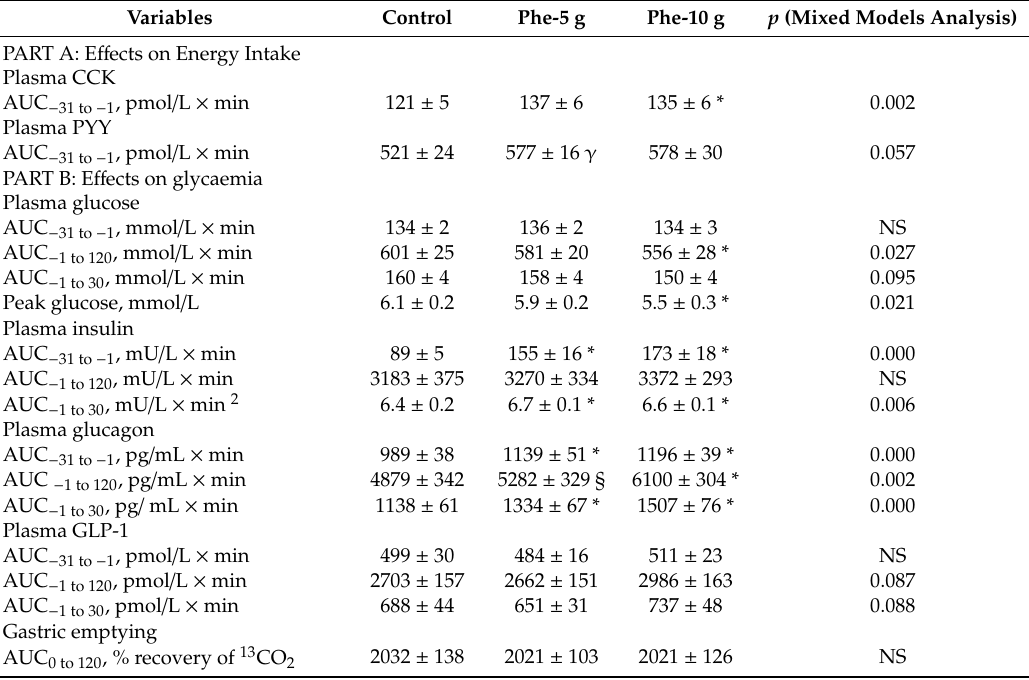
Table 2. Plasma CCK and PYY concentrations (part A), and plasma glucose, insulin, glucagon and GLP-1 responses to, and gastric emptying of, a mixed-nutrient drink (part B), after intragastric infusion of phenylalanine, at doses of 5 g (Phe-5 g), or 10 g (Phe-10 g), or control 1. Variables Control Phe-5 g Phe-10 g p (Mixed Models Analysis) PART A: E ff ects on Energy